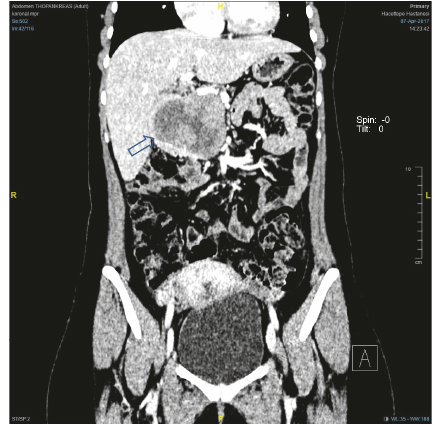
Figure 2: Coronal section of the pancreatic tumor (arrow).